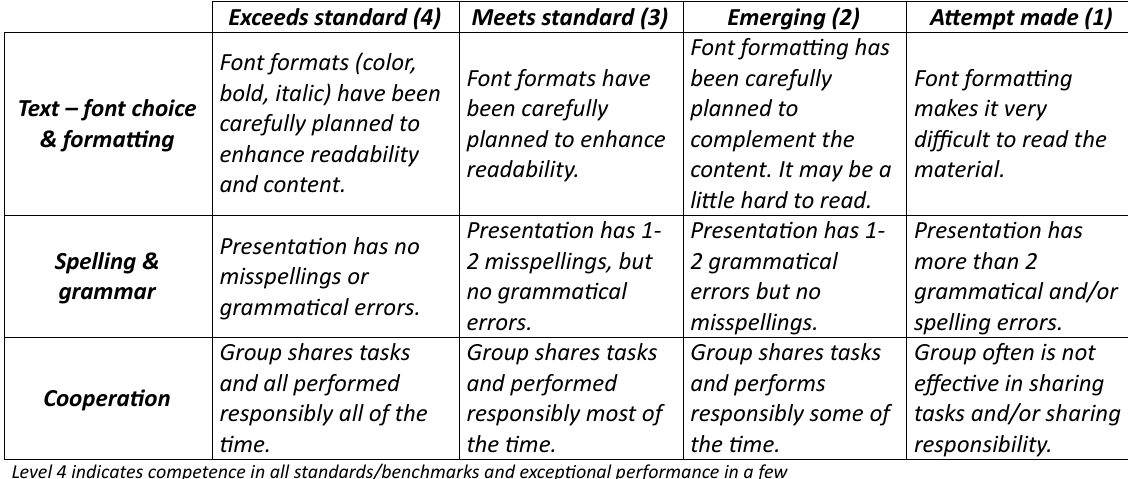
Table 4. Sample Powerpoint Slide Grading